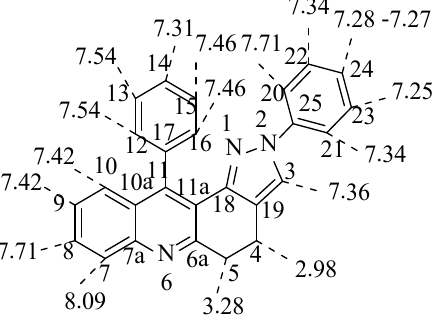
Figure7: Summary of Proton d Values of 6a.